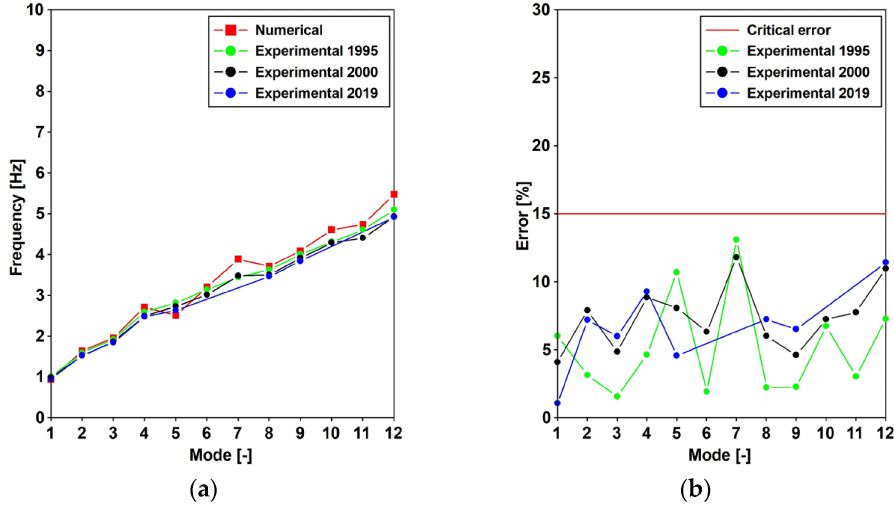
Figure 10. The modal frequencies [Hz]: the numerical vs. the experimental values, and the percentage error.